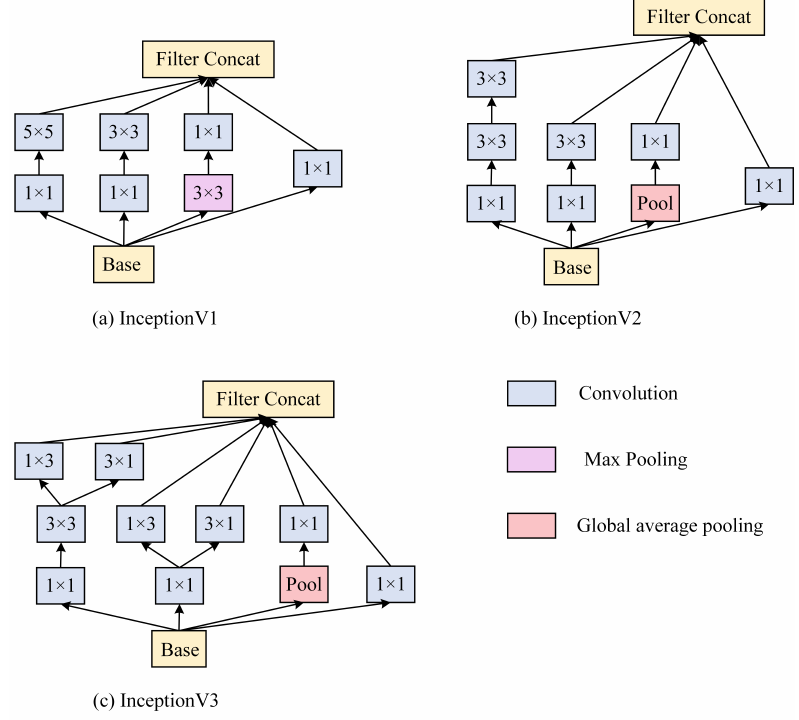
Figure 11. InceptionV1 to V3